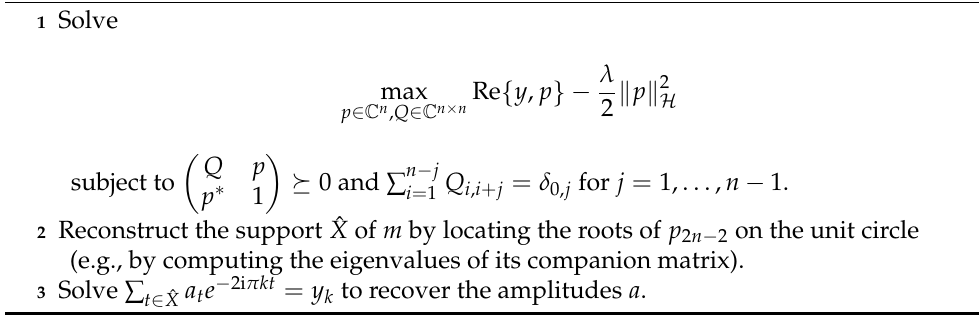
Algorithm 1: Interior Point Method applied to the BLASSO.